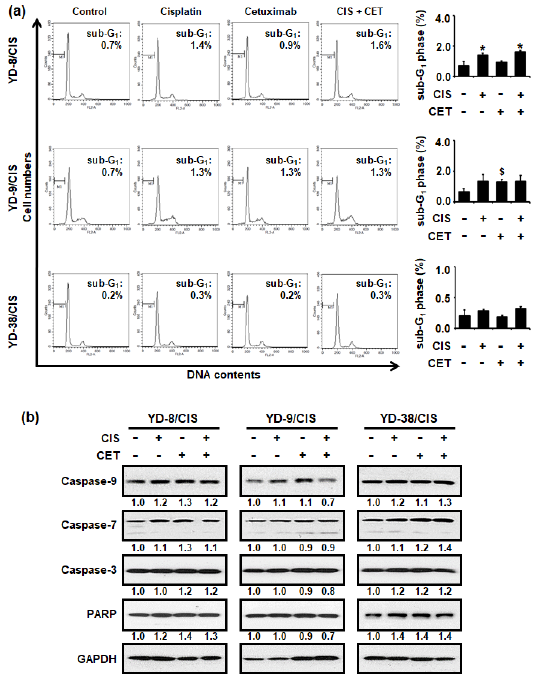
Figure 3. Cisplatin (CIS) (1 µ g/mL) and cetuximab (CET) (200 µ g/mL) combination for 72 h did not affect apoptosis in cisplatin-resistant OSCC cells. ( a ) Left panel, the cytotoxic effect of cisplatin and/or cetuximab in cisplatin-resistant OSCC cells was measured using PI staining assay. A sub-G1 peak may be present when cells enter apoptosis in the G1 phase. Right panel, graph shows quantitative results for left panel (mean ± SD; n = 3). * p < 0.05 versus non-treated group in YD-8/CIS cells, # p < 0.05 versus non-treated group in YD-9/CIS cells, and $ p < 0.05 versus non-treated group in YD-38/CIS cells. ( b ) Levels of apoptosis signaling pathway proteins (Caspase-9, -7, -3, and poly (ADP-ribose) polymerase (PARP)) and glyceraldehyde-3-phosphate dehydrogenase (GAPDH) in cell lysates from all three cell lines treated with cisplatin and/or cetuximab for 72 h were determined using Western blot assay. Western blot results were quantified using Image J software. The numbers represent the ratio of the optical density of cisplatin and/or cetuximab-treated to non-treated cells normalized by GAPDH.